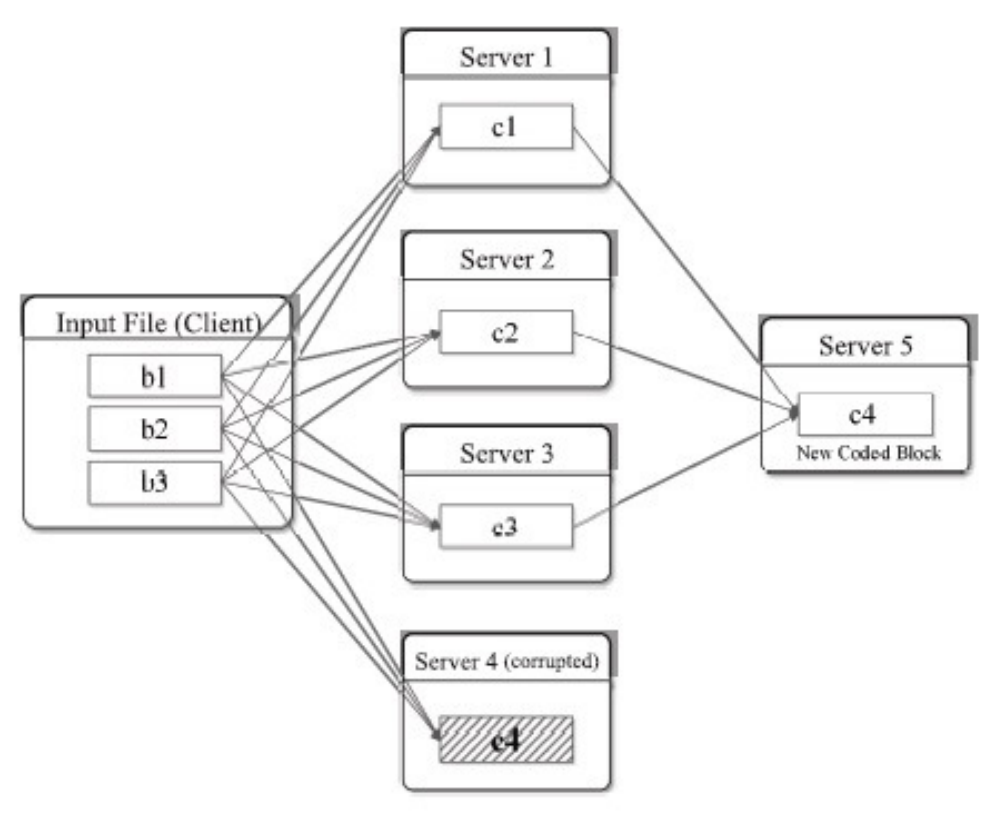
Fig. 5 Erasure Coding-Based Distributed Storage